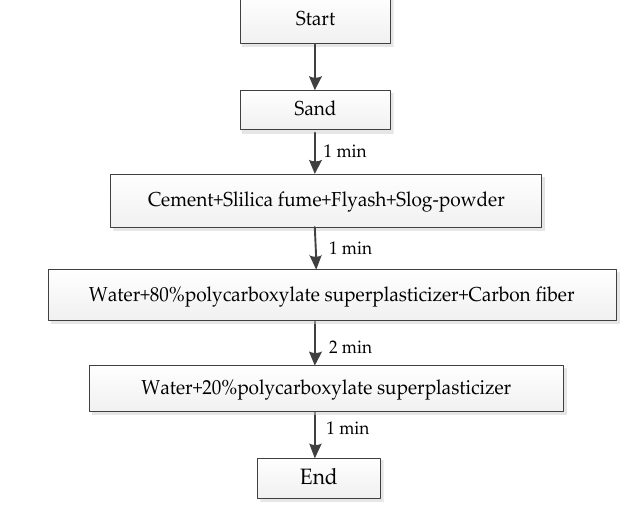
Figure 1. Stirring process.